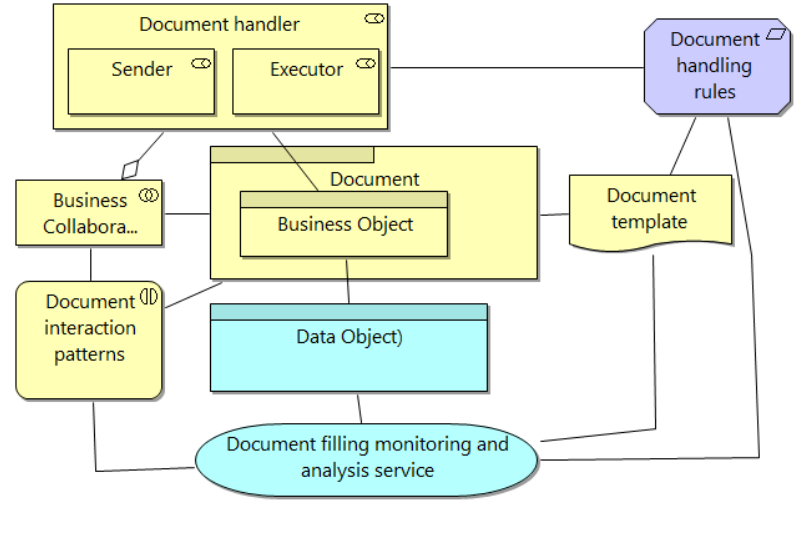
Figure 4. Enterprise model elements to be monitored and vendor's service (document oriented